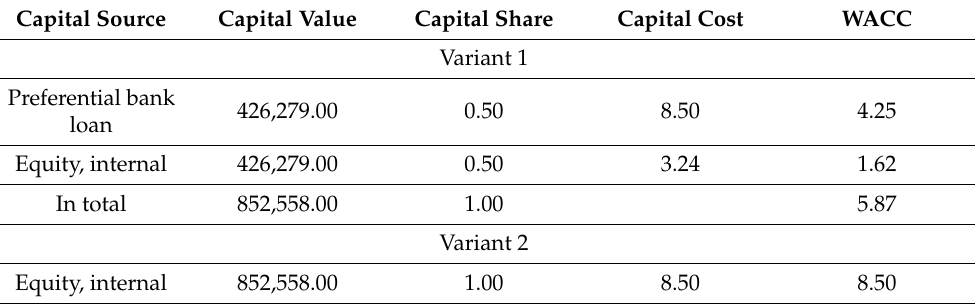
Table 21. Sources of capital, their value, structure and cost as well as the weighted average cost of capital in possible variants of project financing. Source: designed by authors.